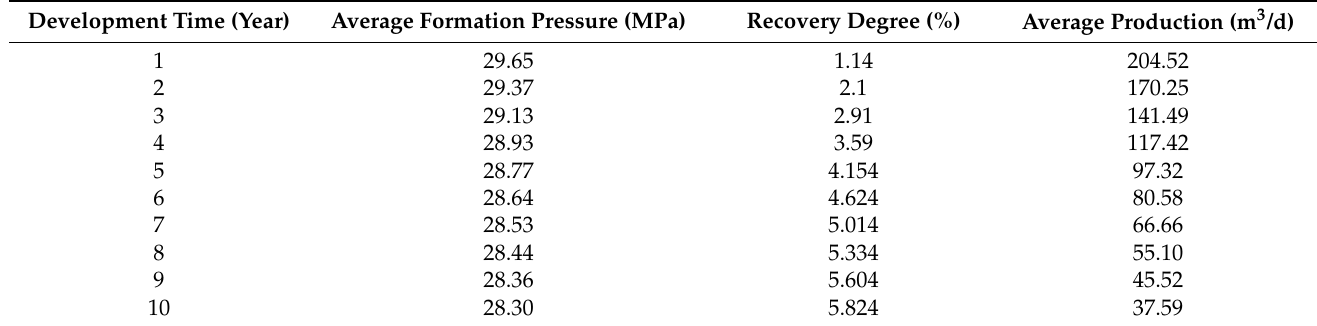
Table 3. Production prediction with constant bottom hole flowing pressure.